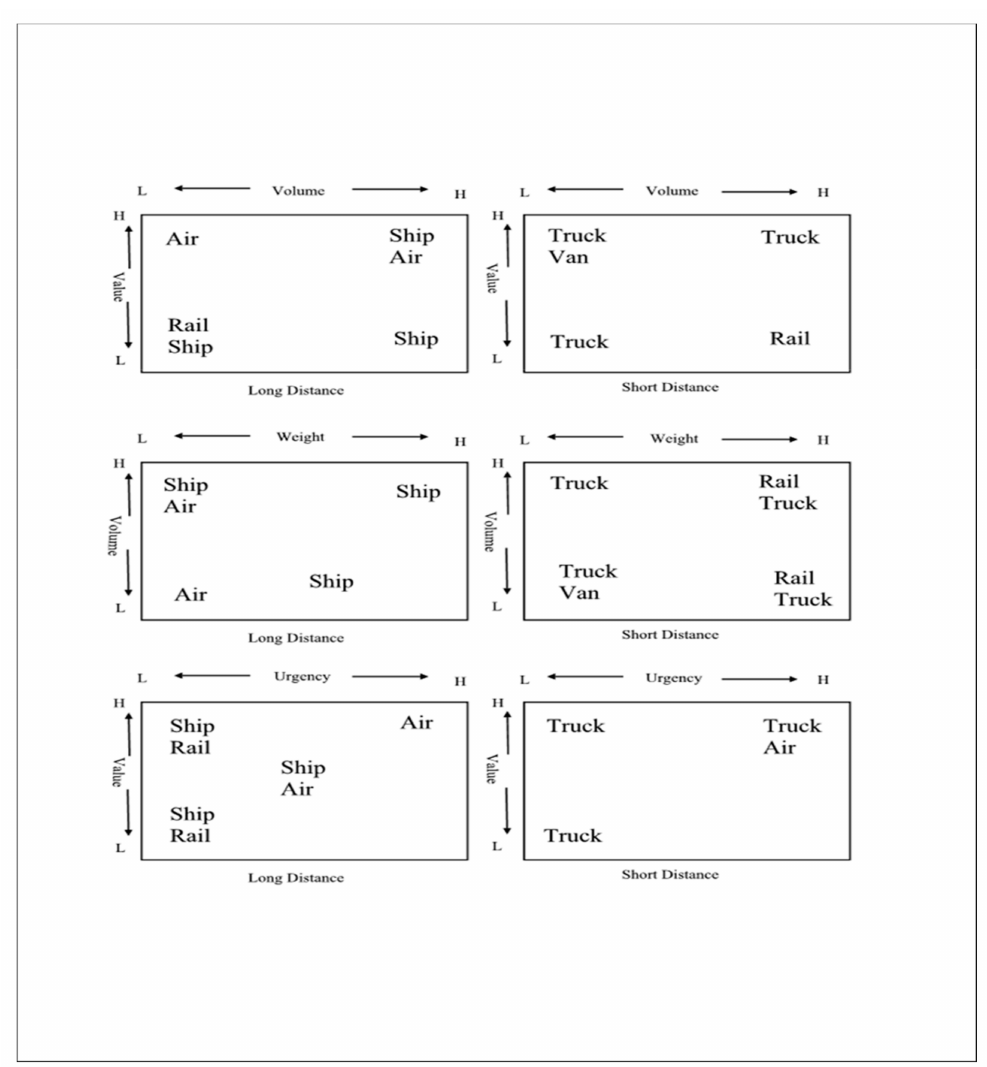
Figure 1. Synthesis of modal decision-making. ( Source: Adapted from McKinnon, 1989